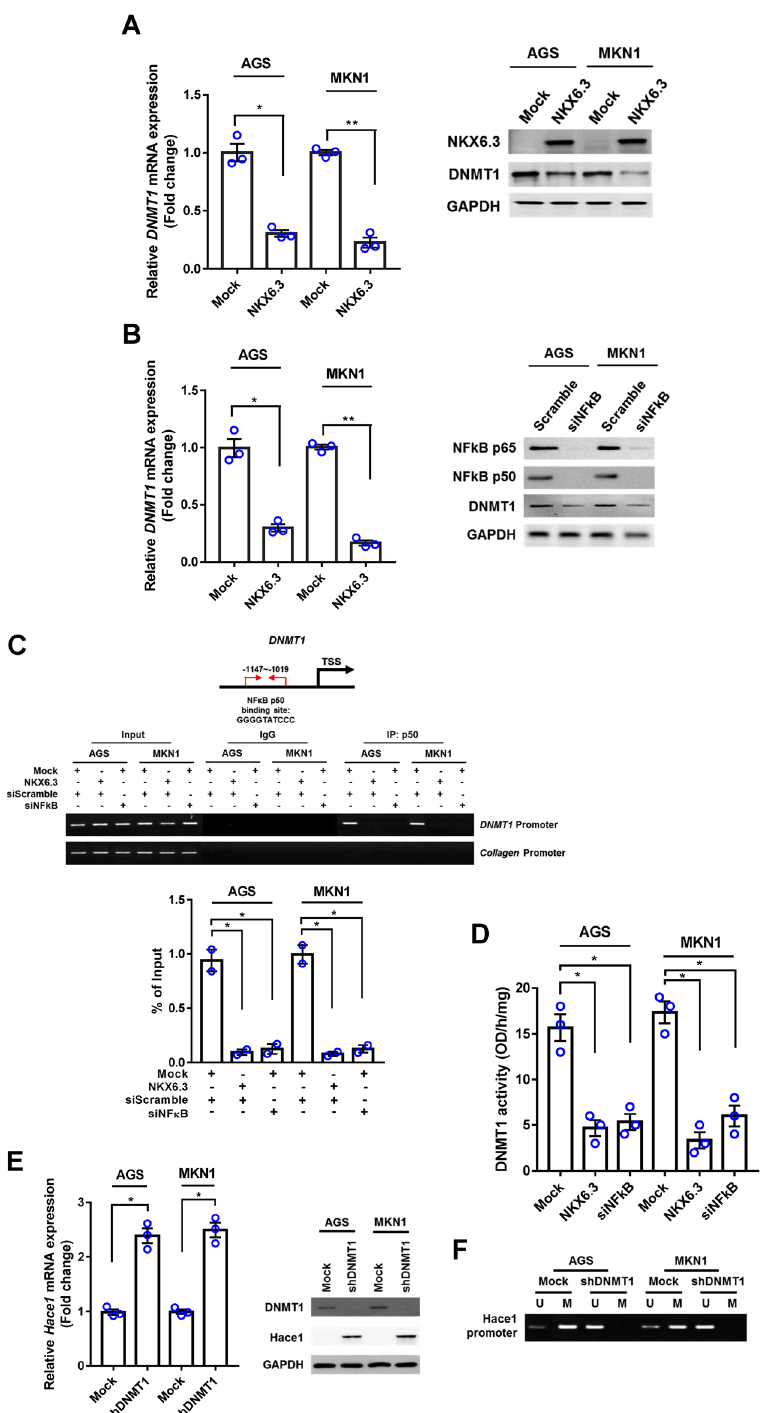
Figure 3. NKX6.3 inhibits the expression and activity of DNMT1. (A) NKX6.3 reduced DNMT1 mRNA and protein expression in AGS and MKN1 cells. (B) Inactivation of NF-kB significantly decreased DNMT1 mRNA and protein expression in AGS and MKN1 cells. (C) In ChIP assay, NKX6.3 inhibited p50 binding to the promoter region of DNMT1 gene and its inhibitory effect was very similar to that of siNF-kB . Collagen gene was used as a negative control and bands were seen in the input but not in the IgG and p50 precipitated genomic DNA. (D) NKX6.3 expression and NF-kB silencing significantly reduced DNMT1 activity. (E) Inactivation of DNMT1 with shDNMT1 induced Hace1 mRNA and protein expression. (F) DNMT1 silencing induced de-methylation of Hace1 promoter. All results are represented as mean ± SEM from three independent experiments. Each dot plot represents the result from the individual experiment. ** P < 0.01, * P < 0.05, based on the student’s